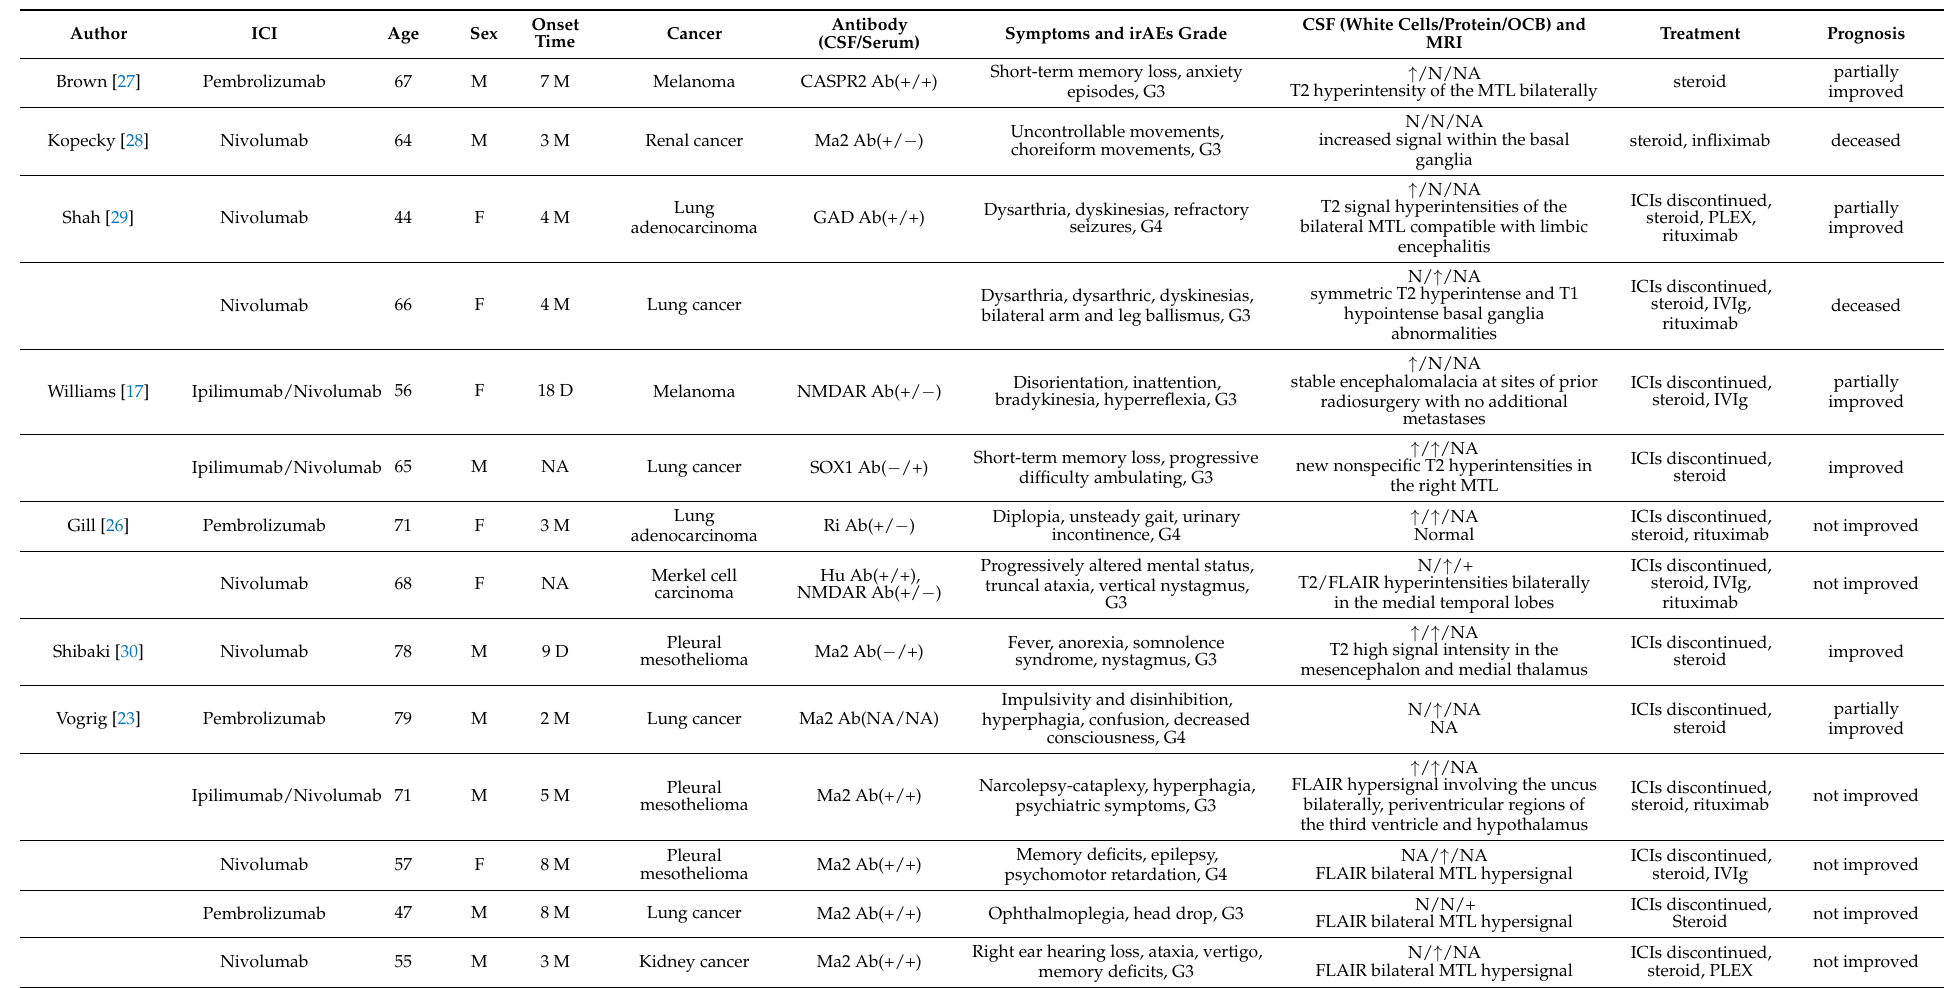
Table 1. ICI-associated